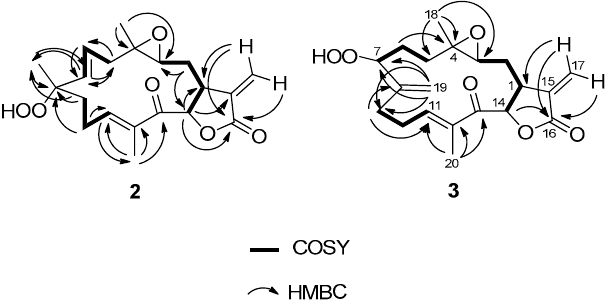
Figure 4. 1 H- 1 H - COSY and 1 H- 13 C-HMBC correlations for compounds 2 and 3 .